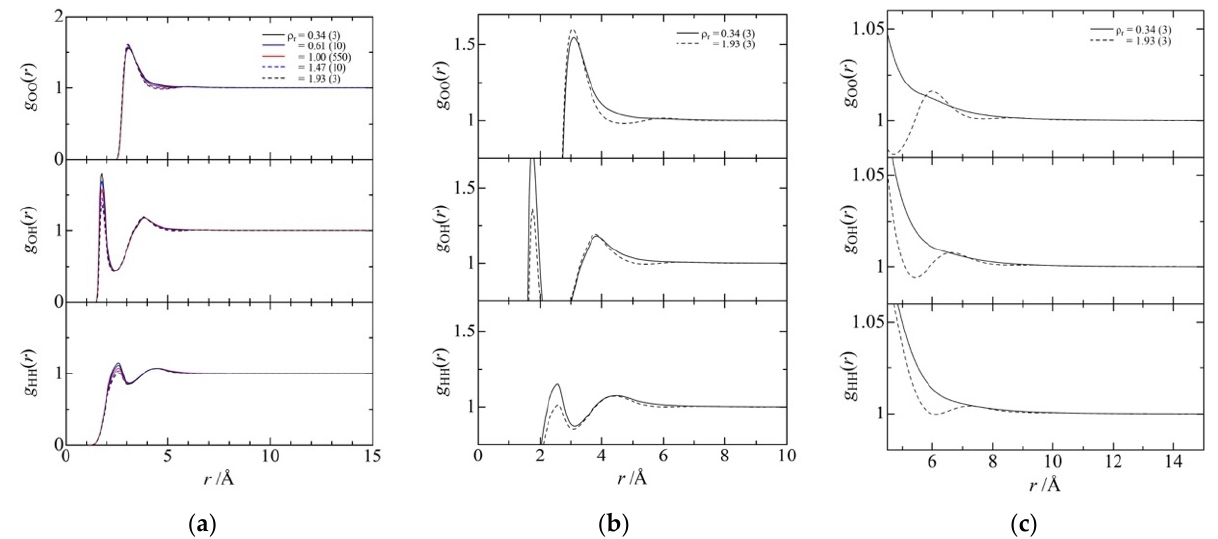
Figure 8. Density dependence of the RDFs between O–O, g OO , O–H, g OH , and H–H, g HH , along an isotherm at 644 K. The results are plotted for the fluid at seven state points. Numbers in parentheses in the figures denote the value of density fluctuation at that point. ( a – c ) are plotted for different ranges, namely from 0 to 20 Å in ( a ), from 0 to 20 Å with y -axis from 0.8 to 1.7 in ( b ), and from 7 to 25 Å in ( c ). These figures are reprinted with permission from JCP , 2014 , 140 , 104511. Copyright 2014 AIP Publishing.